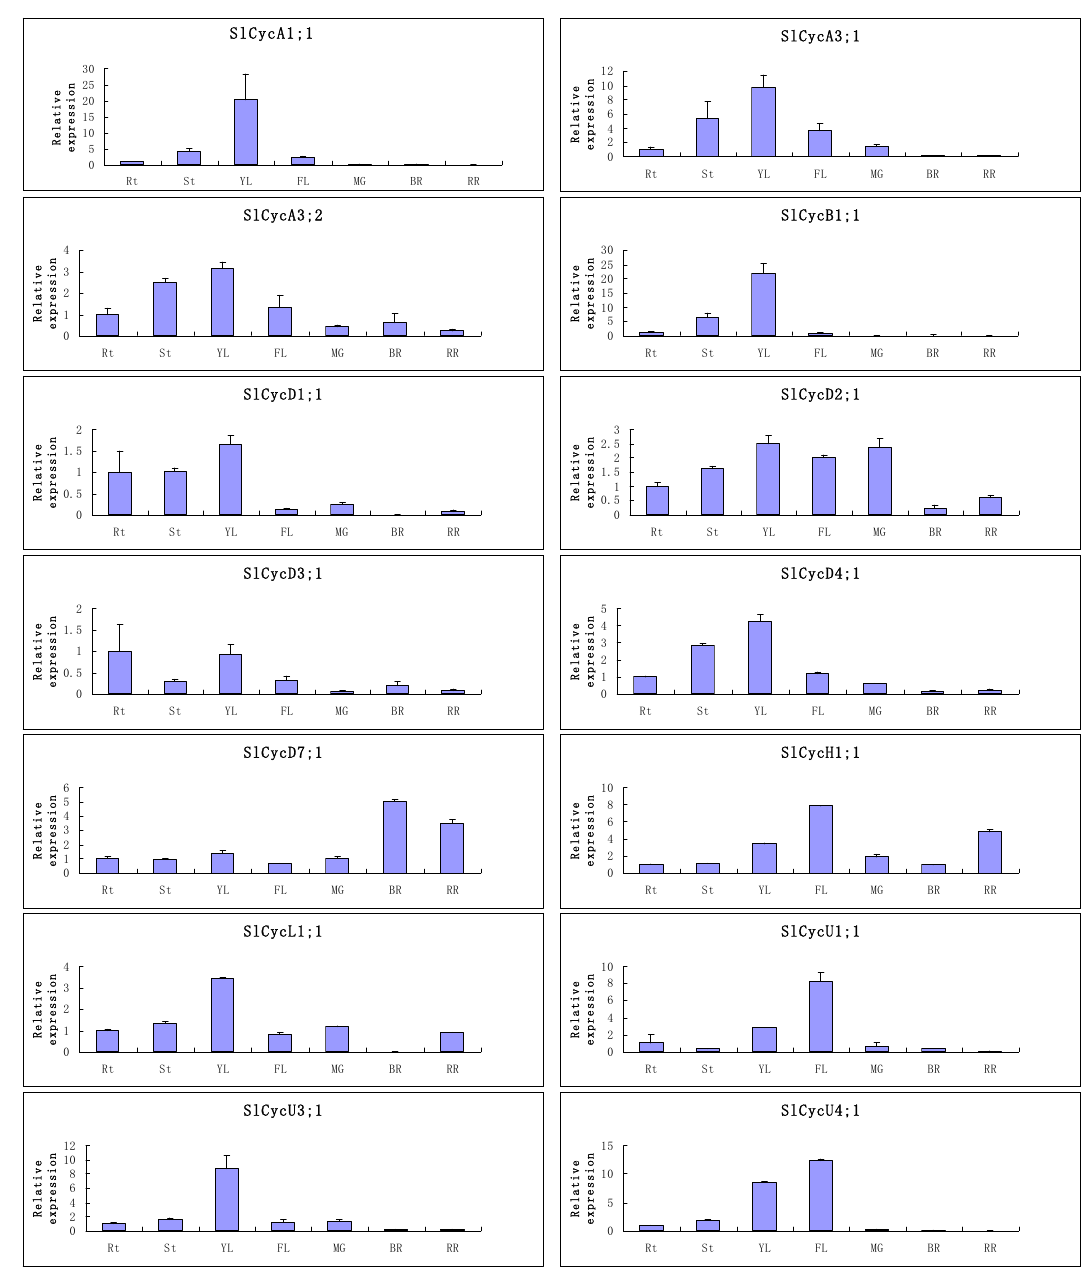
Figure 7. Expression patterns of tomato cyclin genes in different tissues or organs. Rt, root; St, stem; YL, young leaf; FL, flower; MG, mature green fruit; BR, breaker fruit; RR, ripe fruit. Error bars represent standard deviations for three